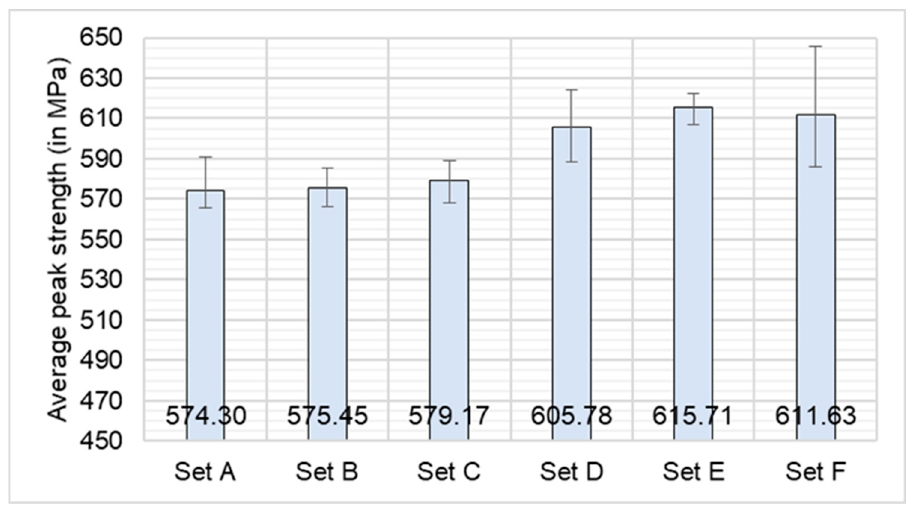
Figure 11. The average peak strength (in MPa) for different samples under uniaxial compression.